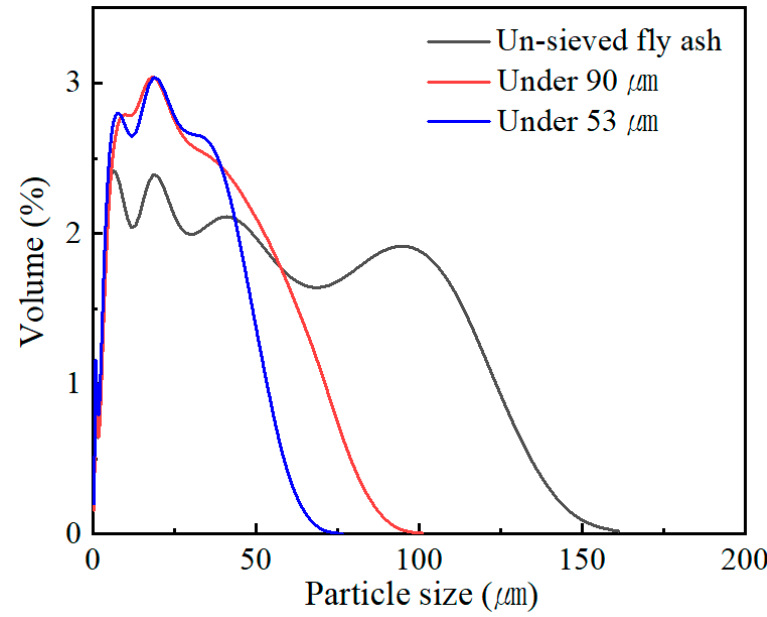
Figure 2. Particle size distribution of un-sieved fly ash, under 90 μ m fly ash, under 53 μ m fly ash. Table 1. Chemical composition of fly ash (unit: wt.%).